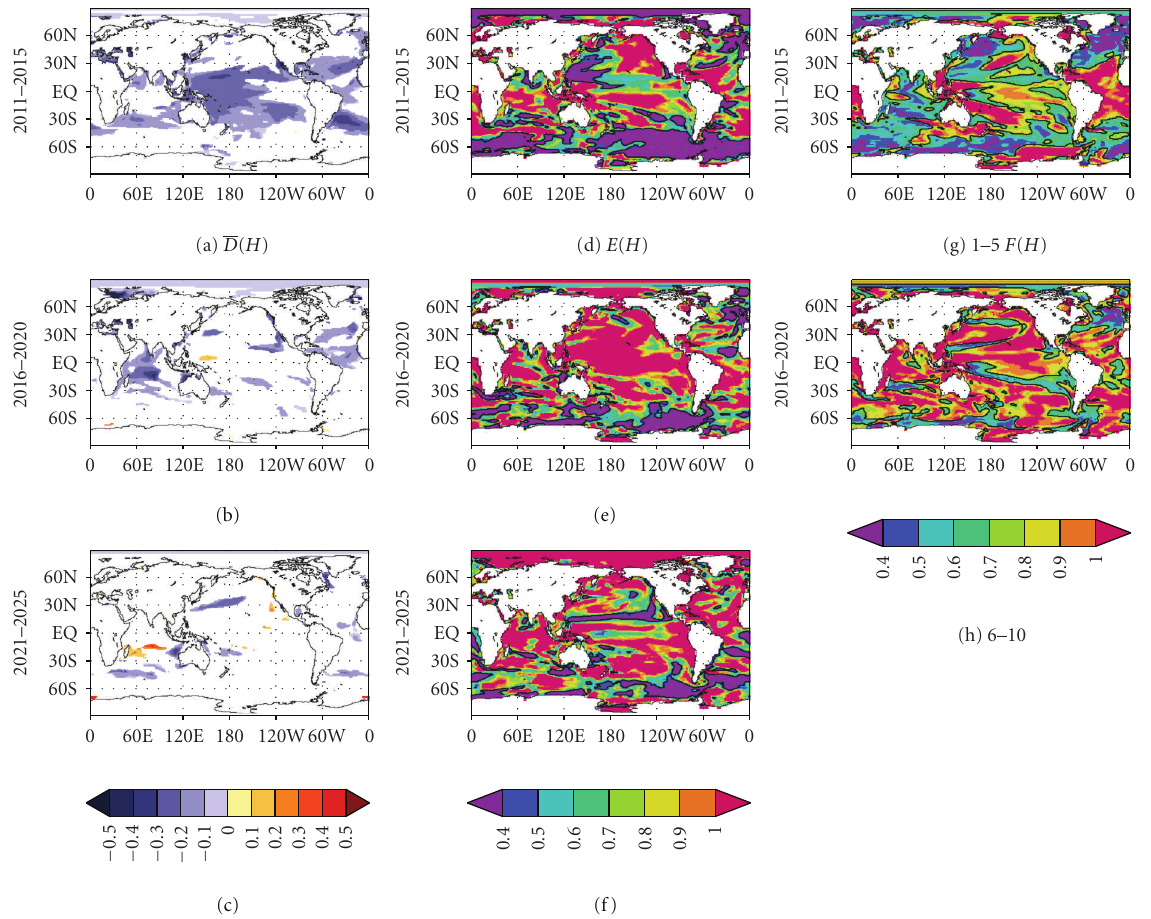
Figure 3: Geographical distributions of changes in 5-yr averaged H. Left panels are the mean responses to the Pinatubo forcing, D ( H ), from the 2011–2015 period to the 2021–2025 period ( ◦ C). Shading shows only significant responses at the ± 10% levels of t -test. Middle and right panels indicate E ( H ) and F ( H ), respectively. Contours denote significant small E ( H ) and F ( H ) at the 10% level of F